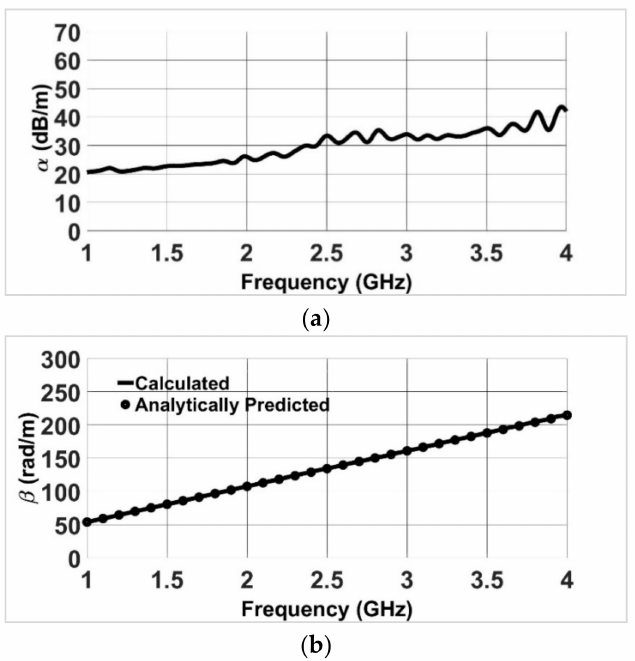
Figure 5. Derived propagation constant profile from measured reflection and transmission coefficients of the 50 Ω TL made of Electrifi and NinjaFlex filaments: ( a ) attenuation constant, and ( b ) comparison of phase constant between calculated and analytically predicted between 1 GHz to 4